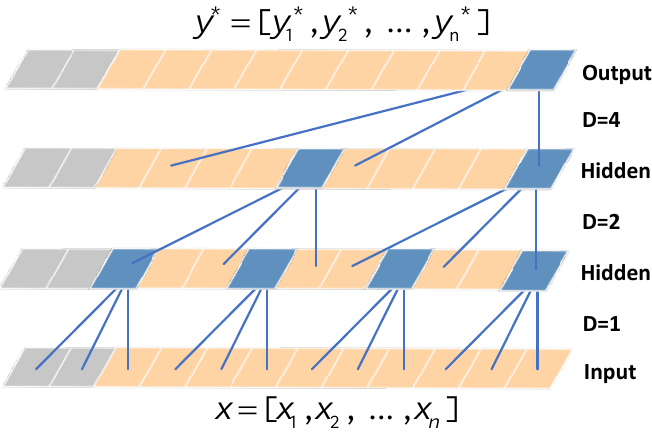
Figure 1. The structure of the causal dilated convolution.